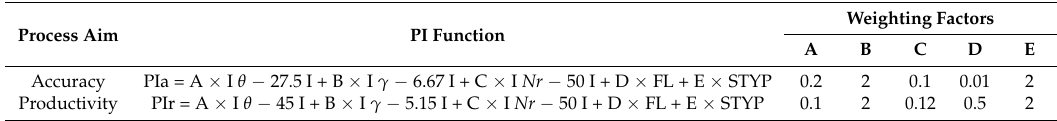
Table 3. Performance Index (PI) functions.